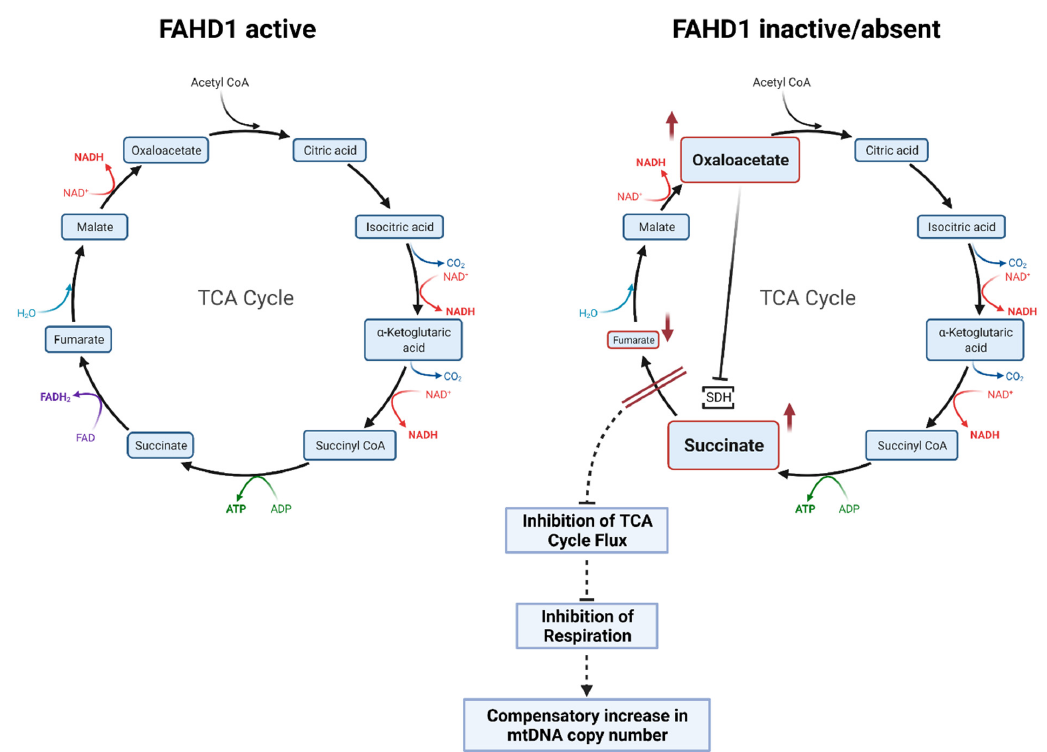
Figure 6. Role of FAHD1-mediated oxaloacetate decarboxylation on TCA cycle flux. When FAHD1 is functional (left panel), excess levels of oxaloacetate (OAA) are converted to pyruvate and CO 2 , keeping OAA concentration below the threshold required for efficient inhibition of succinate dehydrogenase (SDH), thus enabling sustained flux through the TCA cycle. When the FAHD1 gene is deleted, OAA may accumulate to an extent sufficient to inhibit SDH activity, resulting in the accumulation of succinate, reduced levels of fumarate, and reduced flux through the TCA cycle, together leading to an impaired mitochondrial function, the extent of which differs between cell types (see also main text) (Figure adapted from Etemad et al., Mechanisms of Ageing and Development 177 (2019) 22–29). Severe mitochondrial dysfunction due to FAHD1 deficiency will be compensated for by increased mtDNA copy number (as shown here for FAHD1-deficient iPSC; see also main text). SDH: succinate dehydrogenase. This figure as well as the graphical abstract were created with